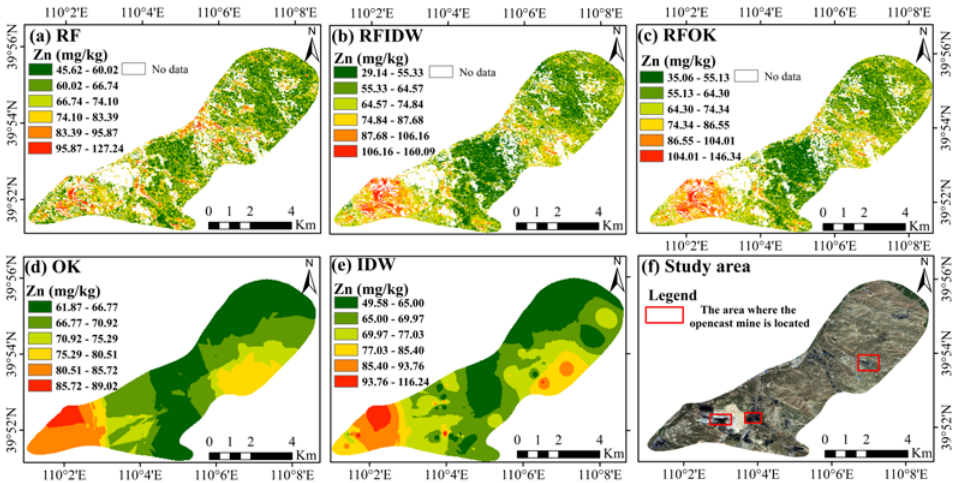
Figure 9. Spatial distribution maps of Zn contents in the research area.